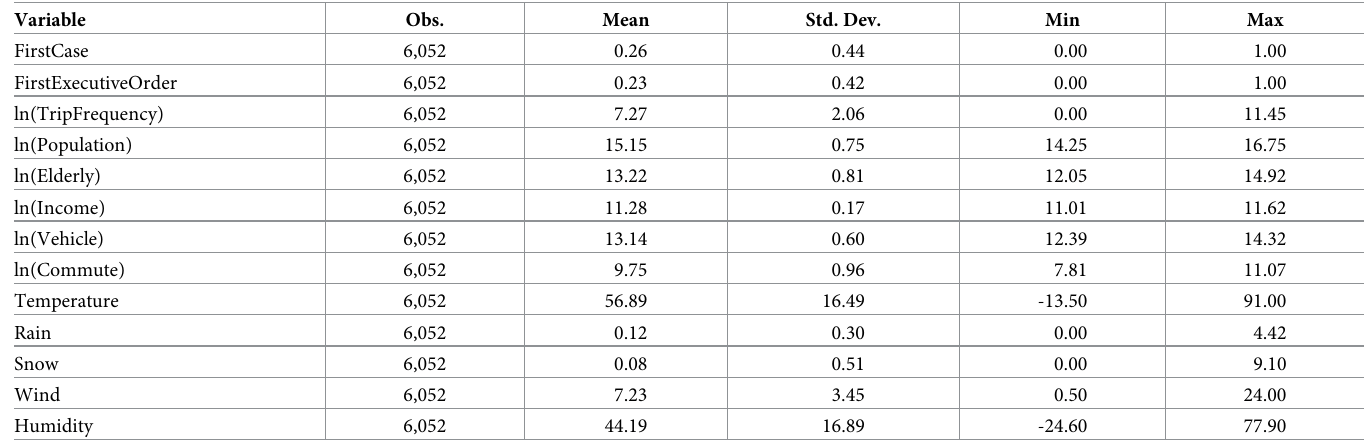
Table 2. Descriptive